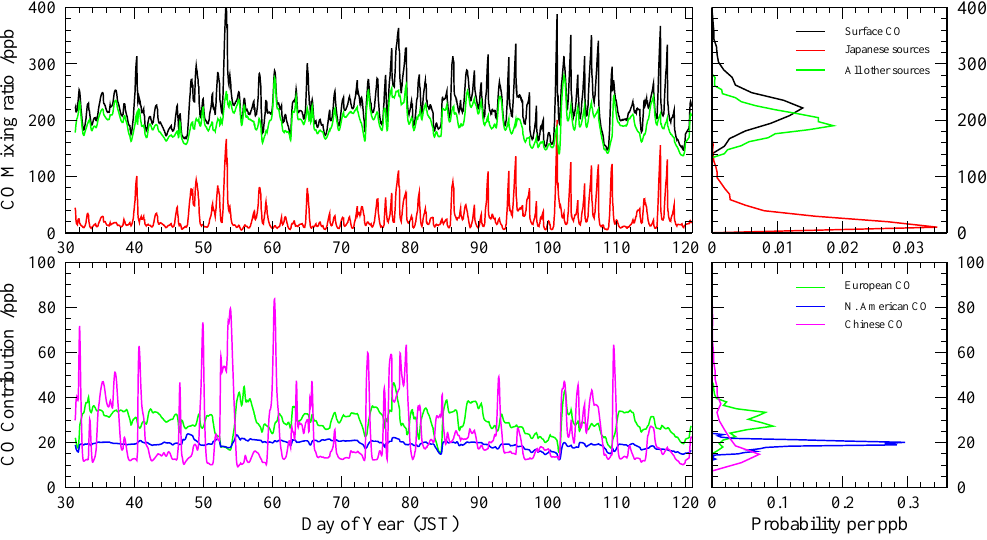
Fig. 7. Hourly mean surface CO mixing ratios in Tokyo in February–April 2001 from the FRSGC/UCI CTM showing (a) total surface CO (black), CO from Japanese sources (red) and background CO from other sources (green), and (b) contributions to CO from Chinese (magenta), European (green), and North American (blue) sources. Right-hand panels show the probability distribution over the three-month period.